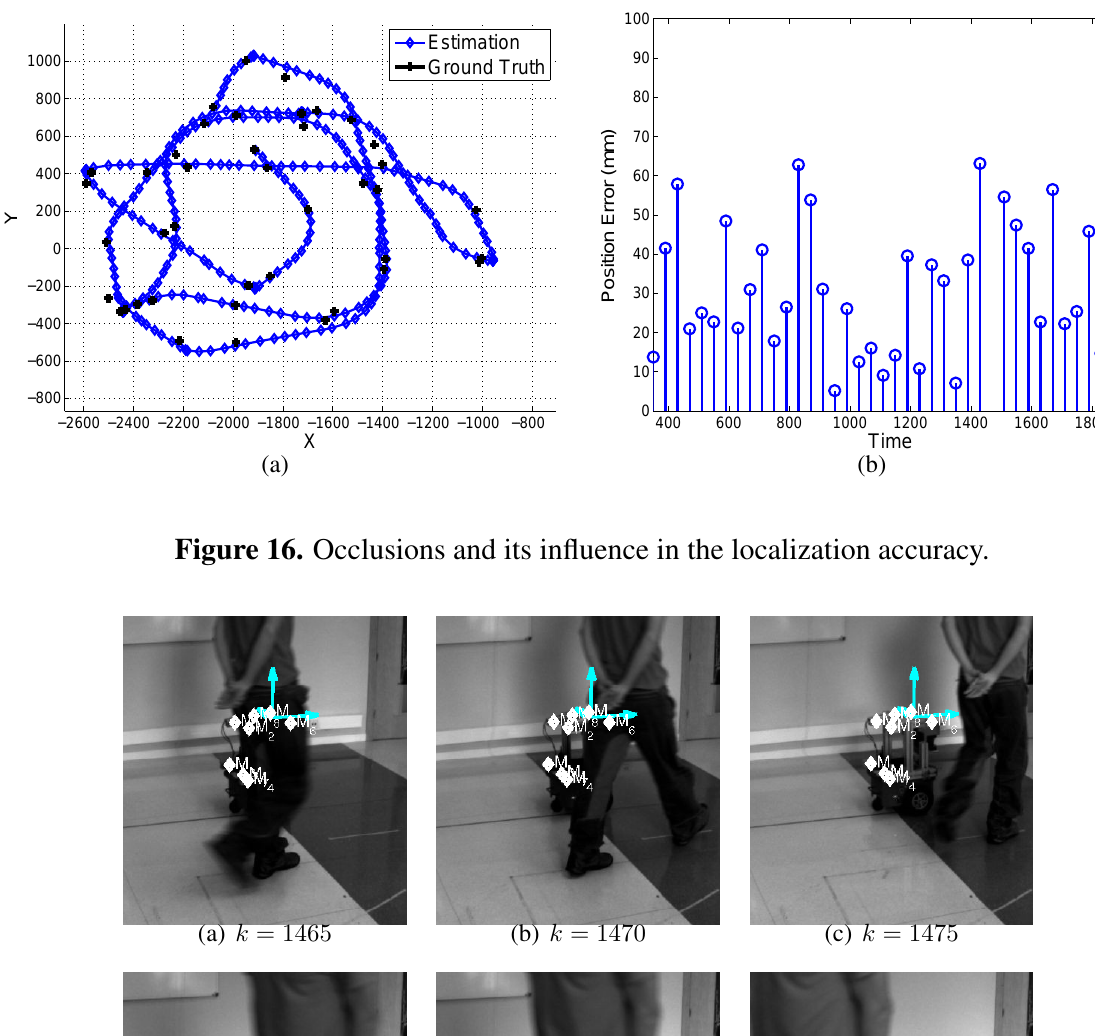
Figure 15. Localization results in an experiment with occlusions.